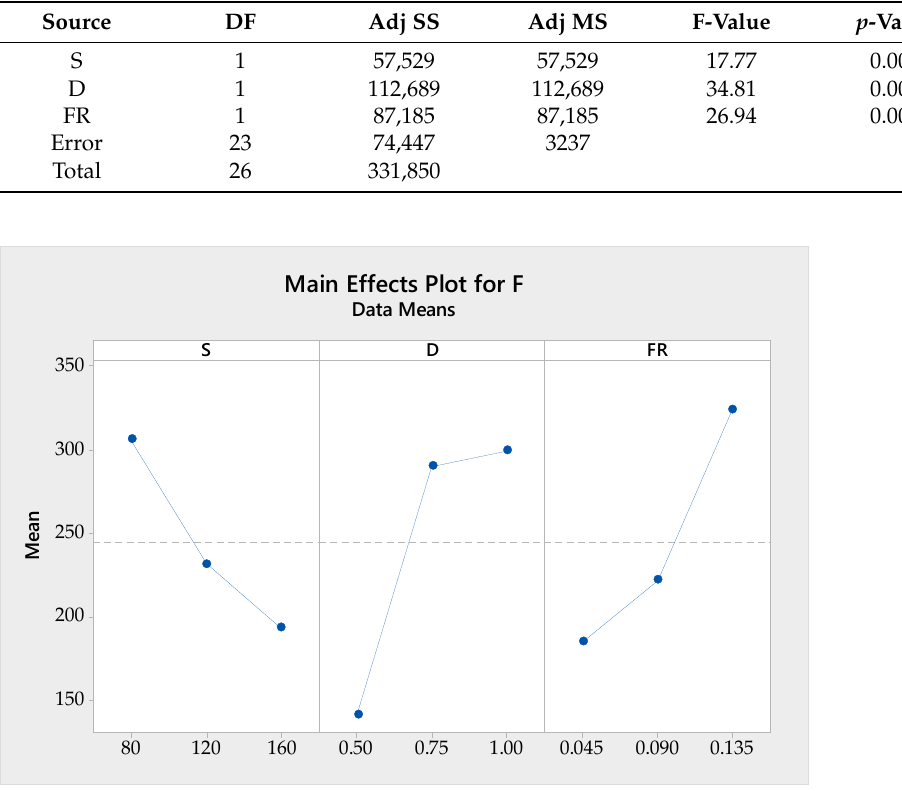
Figure 14. Main effect plots for F using wiper edge.